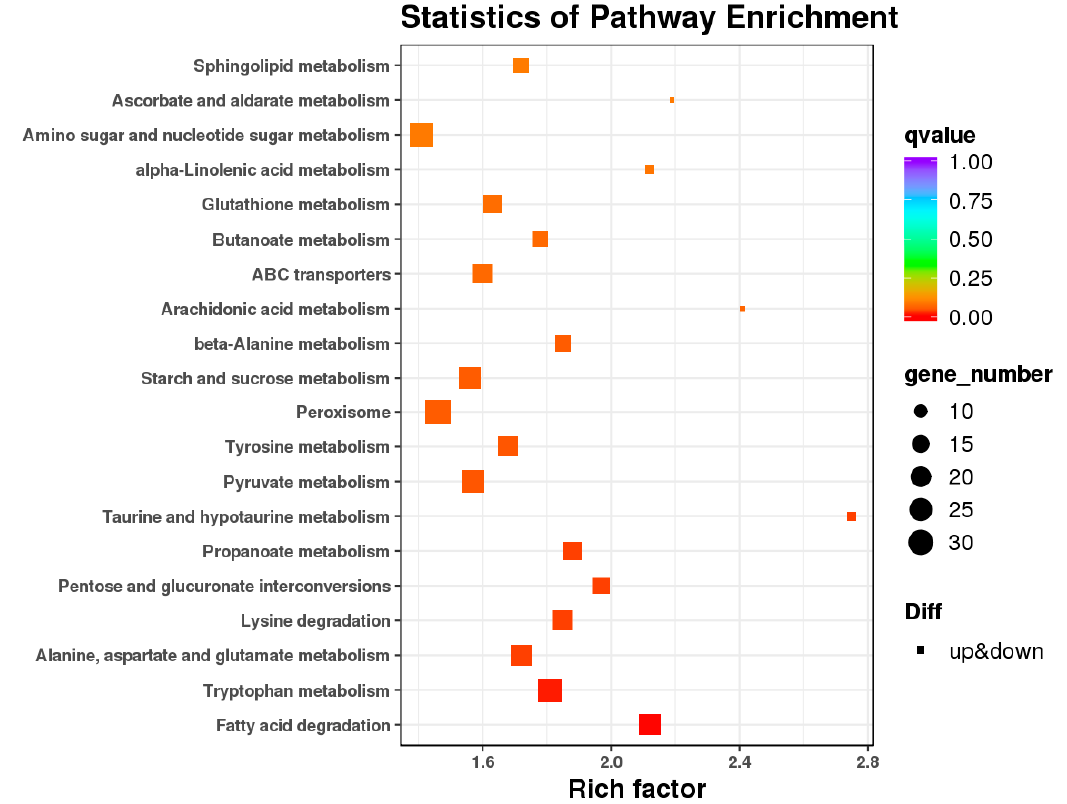
Figure 11. The Scatter diagram of the enriched KEGG pathway of DEGs in IL vs. ML. axis. Pathway; X -axis: Enrichment factor. Enrichment factor is calculated as ratio of DEGs annotated to the term over all DEGs. The color of the dots stands for q-value. ‘Diff’ represents differential expression. Rectangle represents the upregulated and downregulated DEGs in this pathway. IL represents the one-year post-infected larva of H. xiaojinensis by O. sinensis . ML represents the mummified larva of H. xiaojinensis.